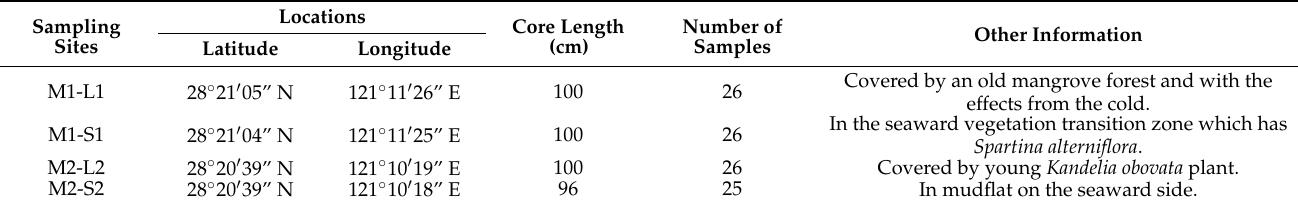
Table 1. Sampling locations and samples